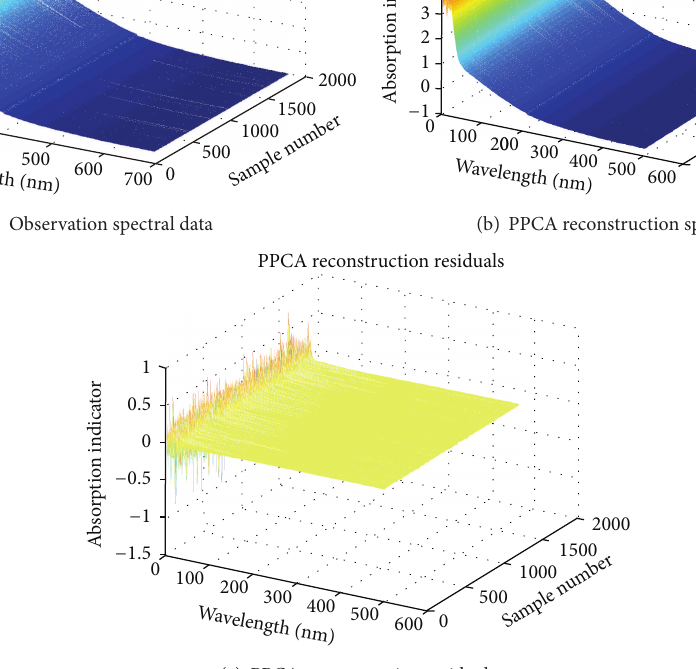
(c) PPCA reconstruction residuals Figure 5: Probabilistic principal component analysis (PPCA).